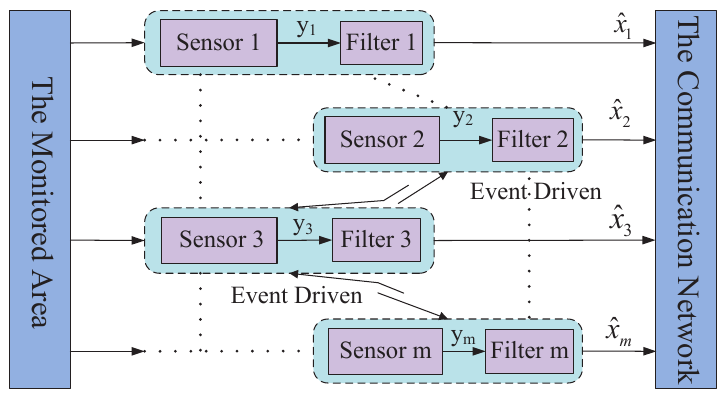
Figure 1. Frame of the event-driven distributed filter in the monitored